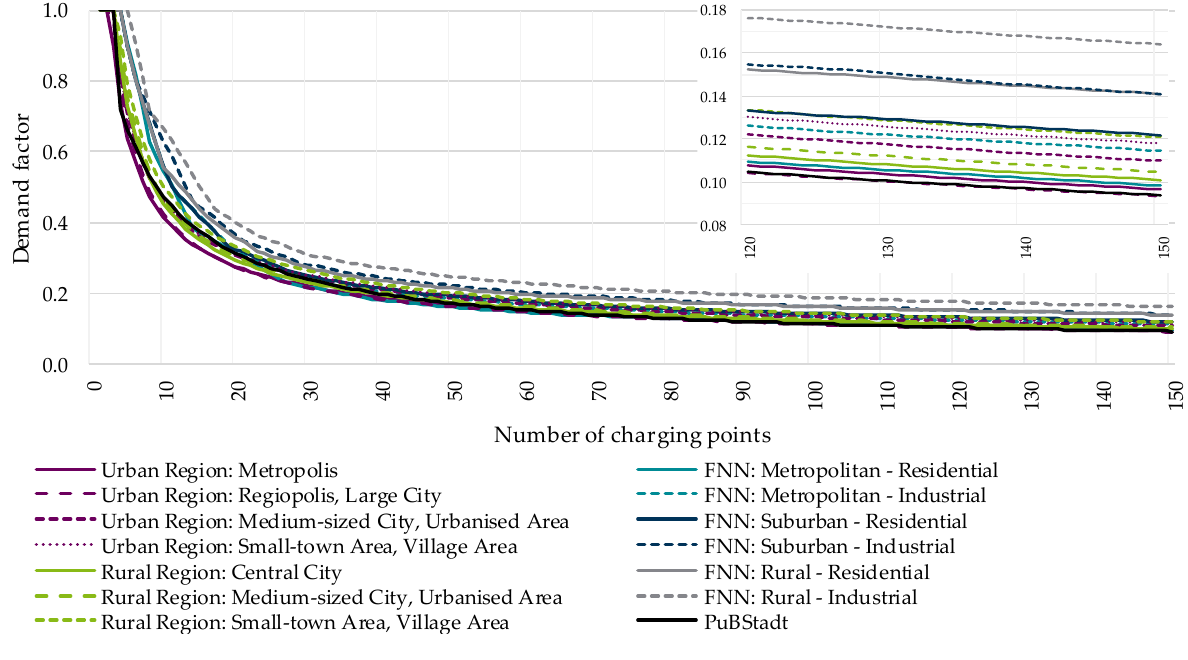
Figure 24. Demand factors (ordinate) for 22 kW charging power with seven different area types, six area types according to FNN and the results from PuBStadt for 150 charging points.